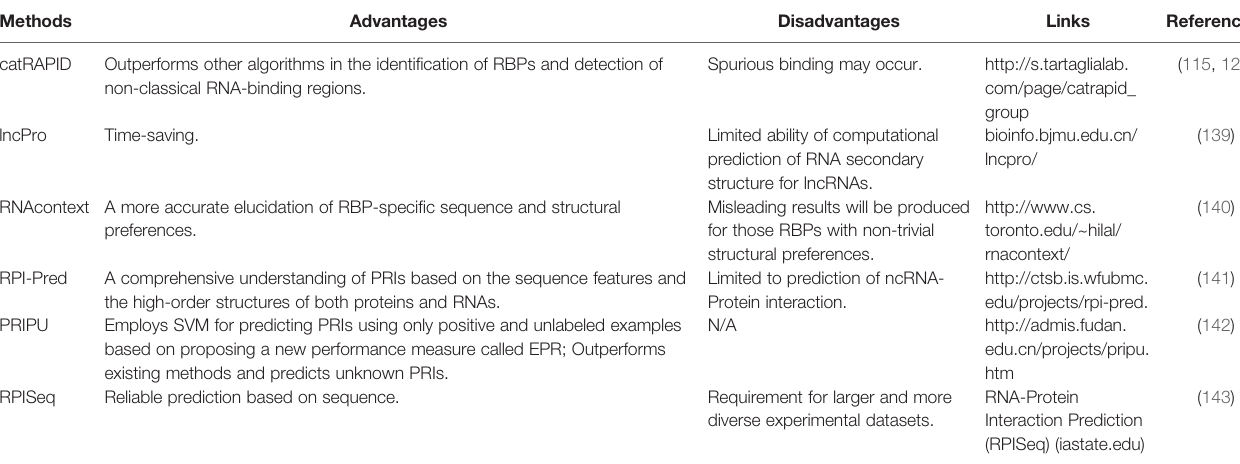
TABLE 4 | Computational tools for the prediction of RNA-protein